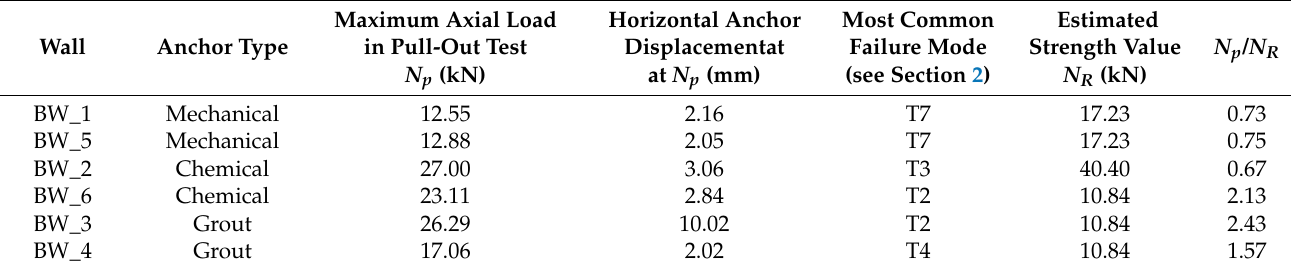
Table 5. Results from pull-out test with horizontal actuator.